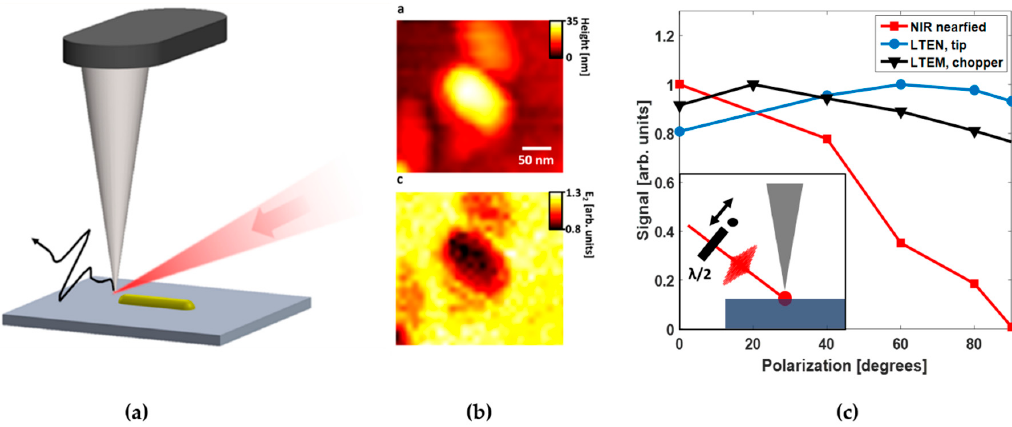
Figure 11. ( a ) Illustration of nanoscale LTEM (Laser THz Emission Microscopy); ( b ) AFM and nanoscale LTEM image referenced at the 2nd harmonic; and ( c ) polarization dependent signals of nanoscale LTEM signal (blue), the NIR near-field signal (red) and the LTEM signal referenced to an optical chopper when turning the polarization of the incident NIR beam as illustrated in the inset. Reprinted with permission from [156] .